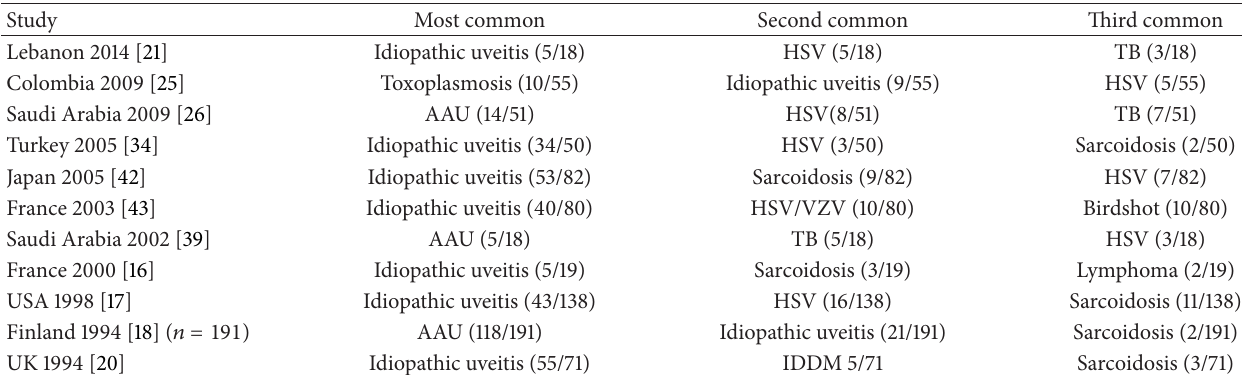
Table 4: Most common diagnosis of uveitis in elderly